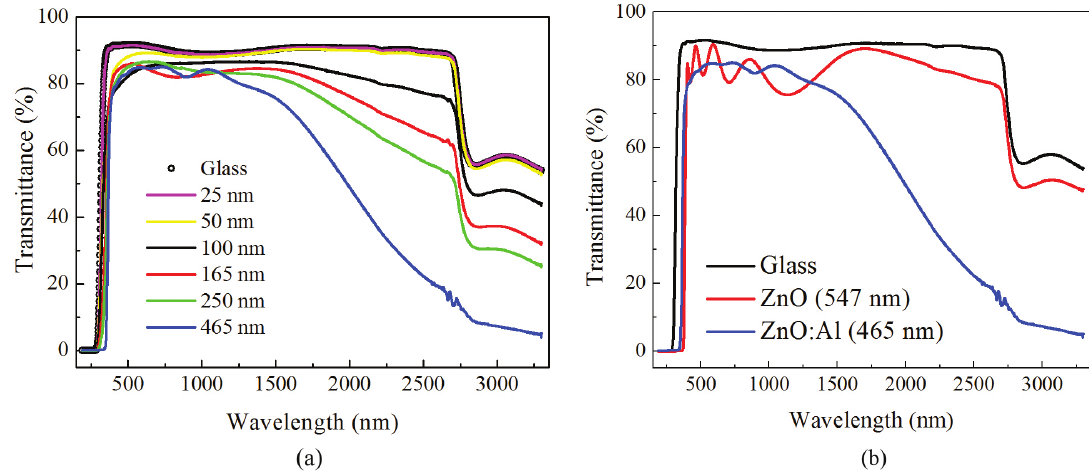
Figure 5. (a) Optical transmittance of ZnO:Al thin films as a function of film thickness. (b) Transmission spectra of the glass substrate, ZnO:Al (465 nm) and intrinsic ZnO (550 nm) thin films.